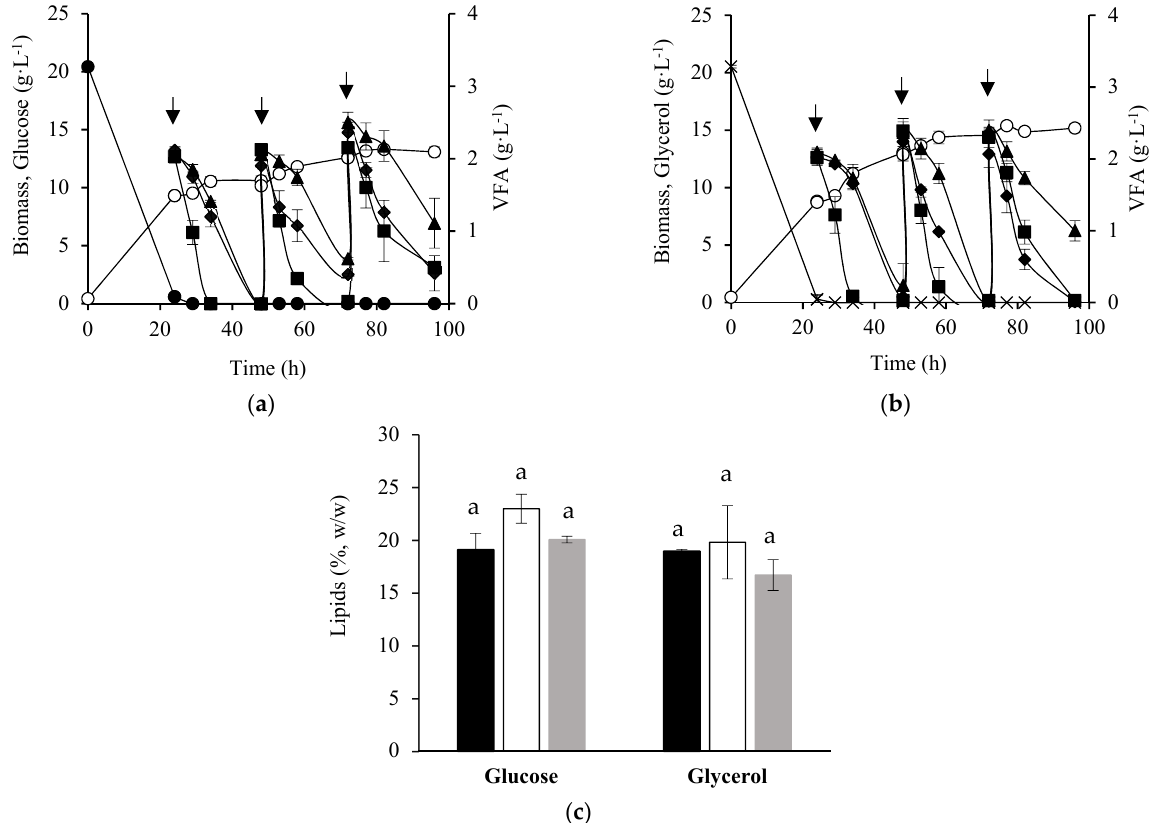
Figure 2. Time course of cellular growth ( ○ ), VFAs ( ■ , acetate; ▲ , propionate; ♦ , butyrate), glucose ( ● ), and glycerol ( x ) concentration obtained in two-stage batch cultures of Y. lipolytica W29. After 24 h of growth in glucose ( a ) or glycerol ( b ), three pulses of a mixture of 6 g·L − 1 VFAs (2 g·L − 1 acetate, 2 g·L − 1 propionate, and 2 g·L − 1 butyrate) was added to the culture medium at 24 h, 48 h, and 72 h. Lipids content of Y. lipolytica cells at 48 h (black bars), 72 h (white bars), and 96 h (grey bars) of cultivation ( c ). The error bars represent the standard deviation of two independent replicates. Bars with the same letter do not present statistically significant differences ( p ≥ 0.05).